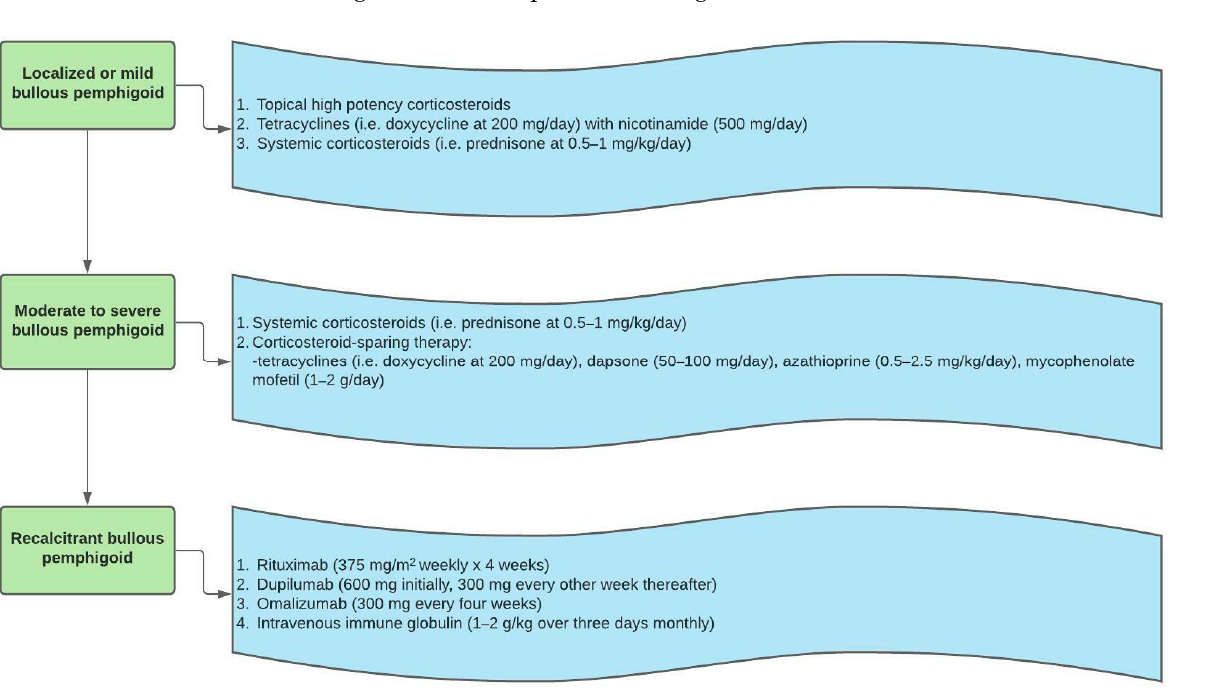
Figure 4. Bullous pemphigoid treatment algorithm.